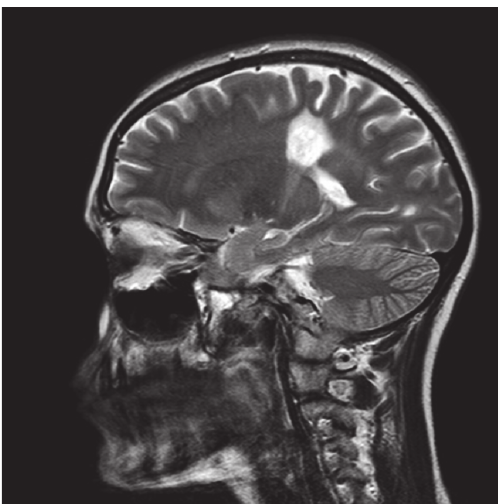
Figure 3: Sagittal head